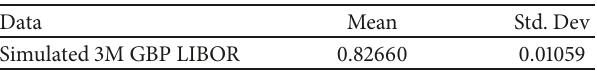
Table 6: Descriptive Statistics of the Simulated 3 Month GBP LIBOR.